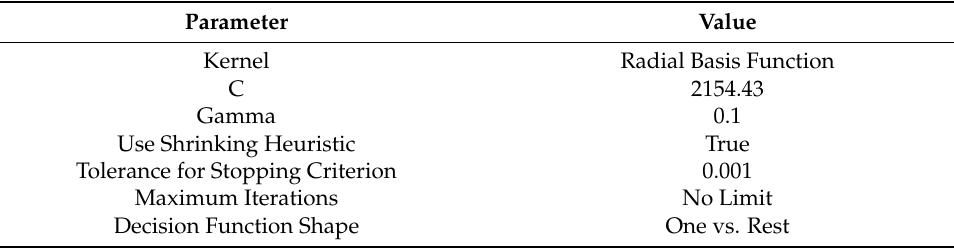
Table 4. Parameters values used for the support vector machine classifier algorithm in scikit-learn. All values are the default options except for C and gamma.